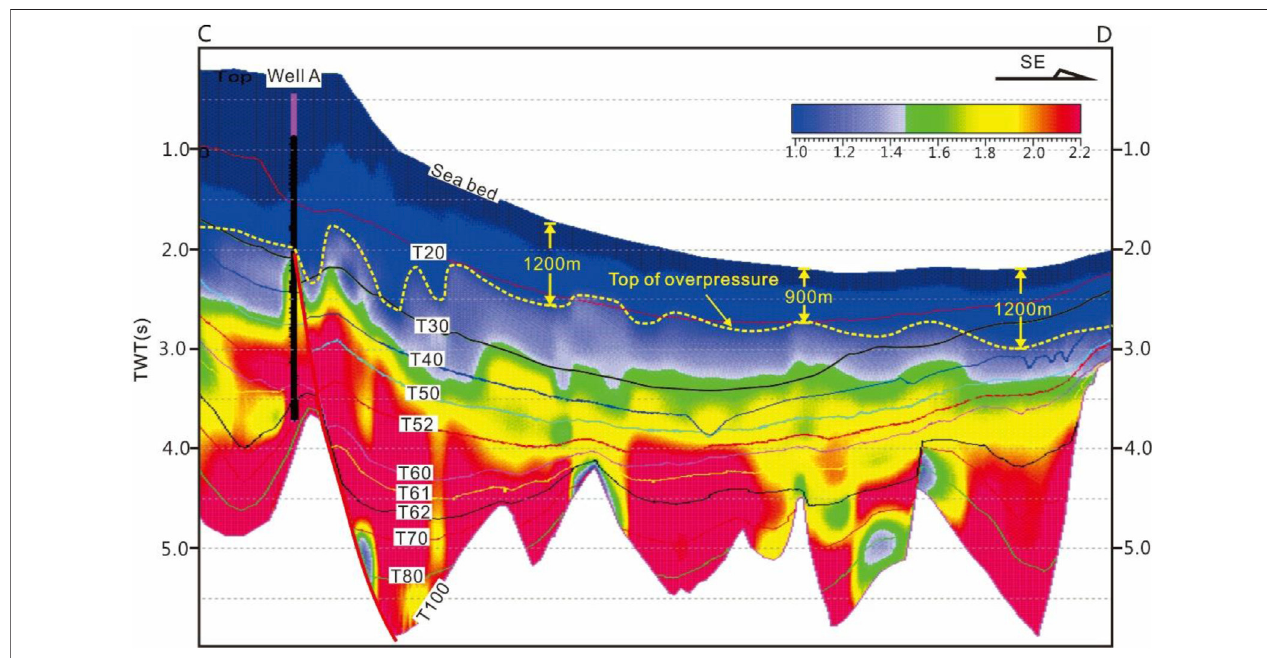
FIGURE 8 | Pressure coef fi cient pro fi le and interpreted top of overpressure of cross section CD, which shows the position of shallow overpressure in the deep water area of the Qiongdongnan Basin. The cross section location is shown in Figure 1 .